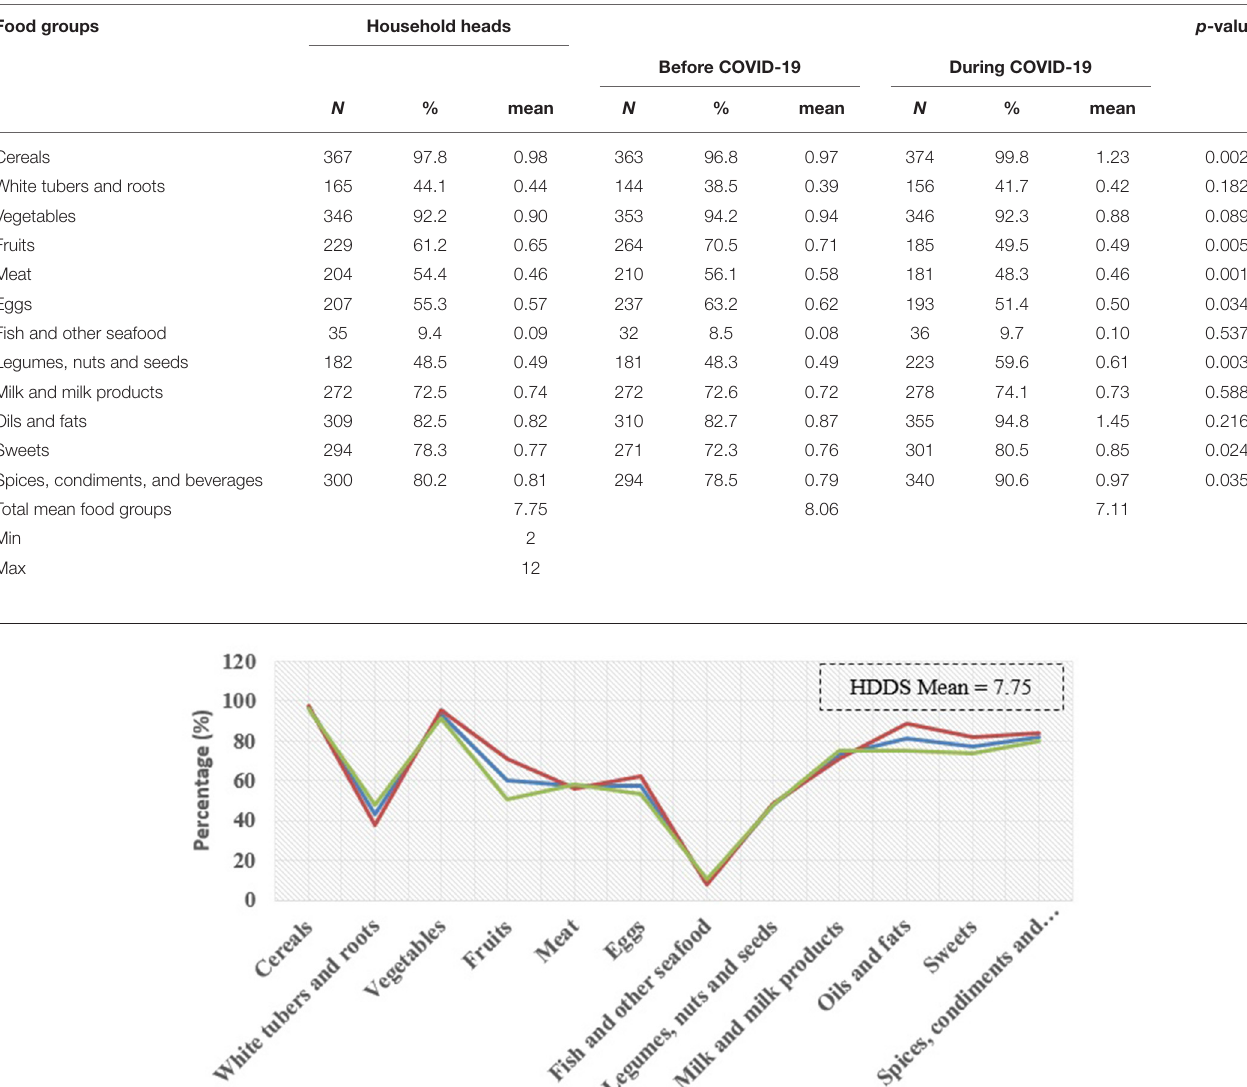
TABLE 5 | Food groups status rural households.